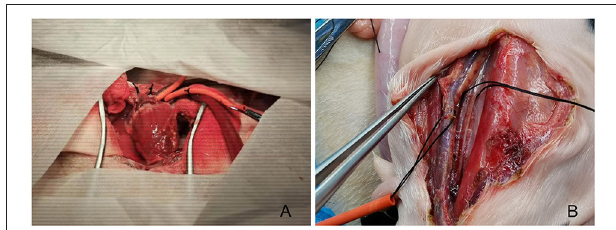
FIGURE 1 | Fetal sheep cardiopulmonary bypass model established with central (A) or peripheral (B) cannulation.